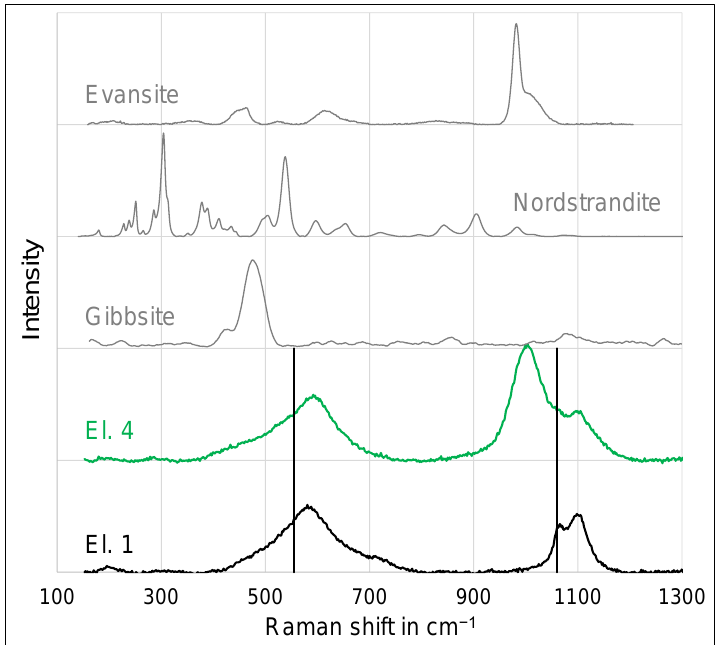
Figure 10. Raman spectra of layers produced in electrolytes 1 and 4 at OCP + 4 V and reference spectra of gibbsite, nordstrandite, and evansite from [31]. The vertical black lines mark characteristic bands of amorphous Al 2 O 3 / γ - Al 2 O 3 according to [33].